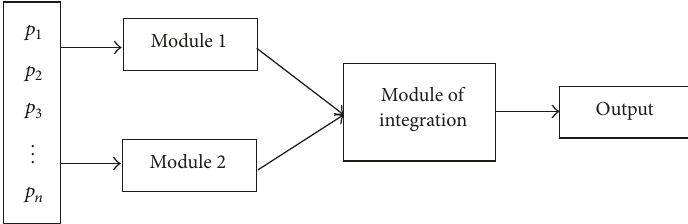
Figure 1: The structure of the MNN.